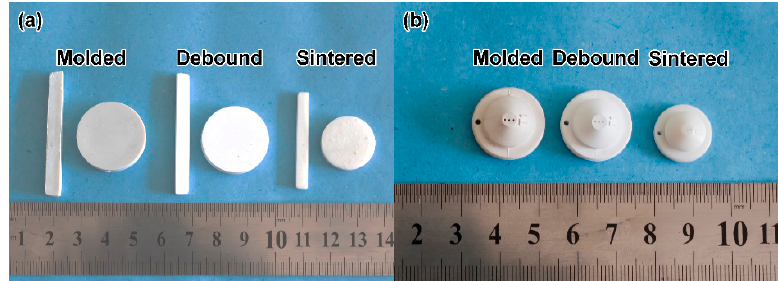
Figure 15. Photographs of molded, debound and sintered ( a ) ZrO 2 samples, ( b ) ZrO 2 ceramic nozzles with multi-micro holes.